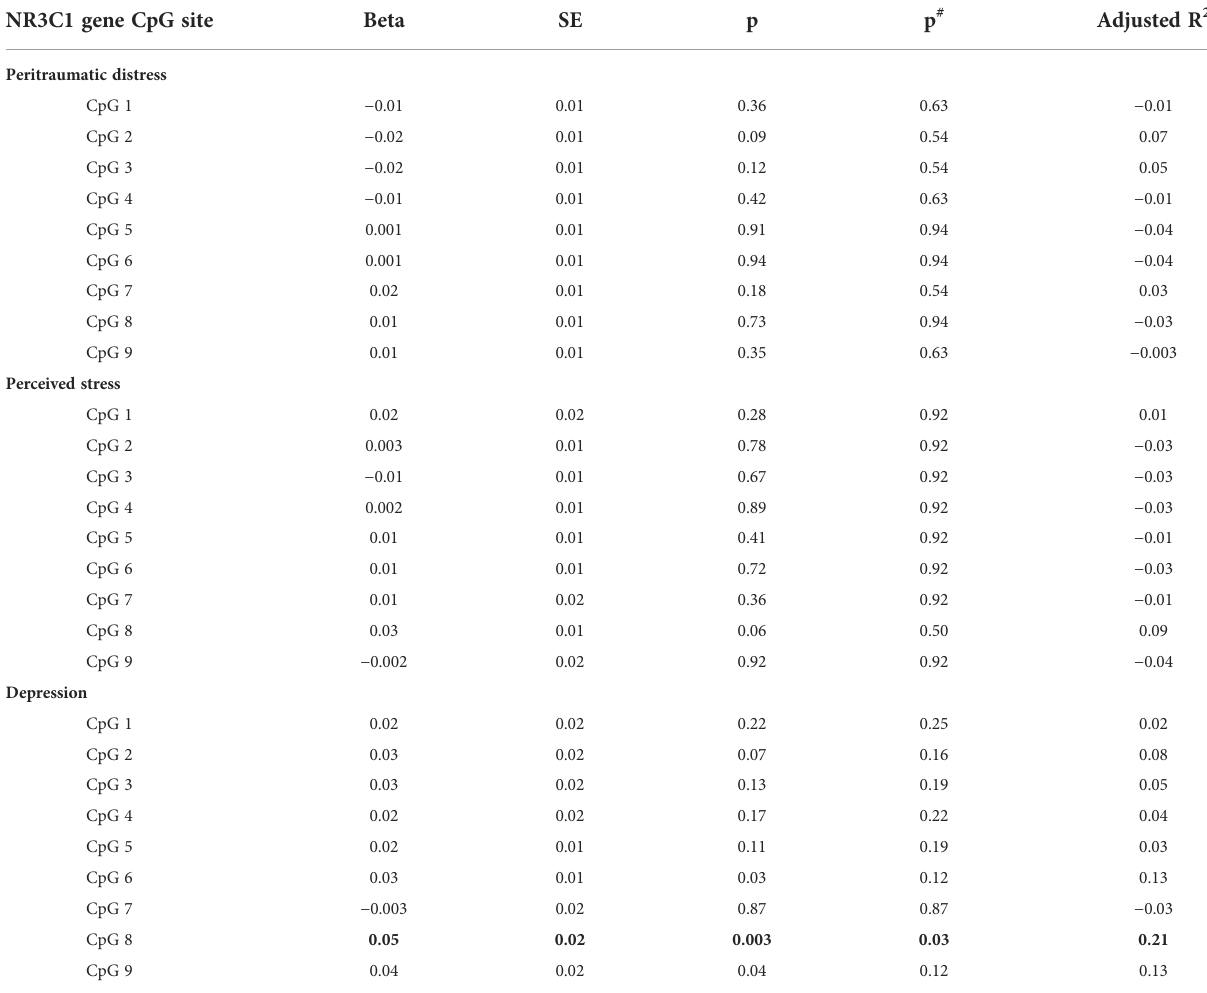
TABLE 3 Effects of peritraumatic distress, perceived stress and depression on NR3C1 gene CpG sites methylation among pregnant women. NR3C1 gene CpG site